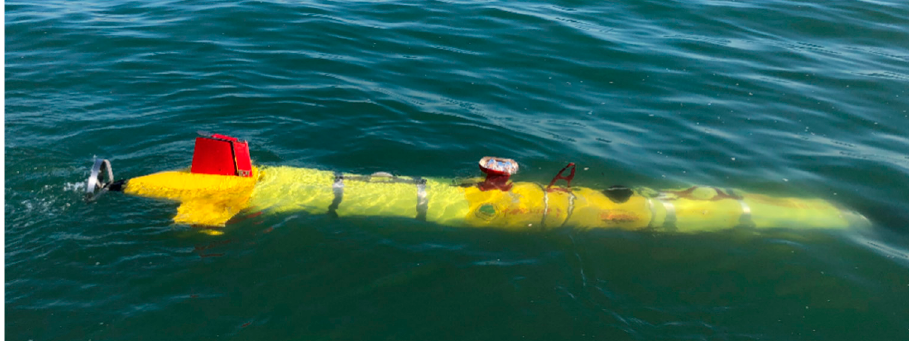
Figure 6. AUV deployment.